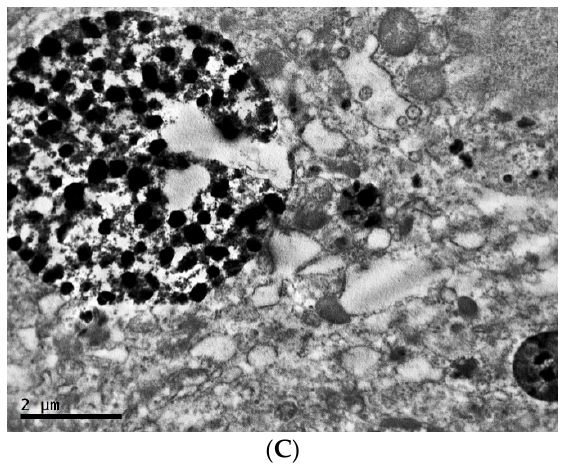
Figure 10. Melanosome complexes of cells of transplantable malignant melanoma B16 under the influence of constant lighting. TEM, ( А )—×10,000, ( B , С )—×14,000. Extensive areas of tumor tissue in this group represent bunches of cells in a state of necrosis—karyorrhexis progressing to karyolysis, lysis of organelles, and destruction of the plasmalemma are noted in groups of cells (Figure 11A,B).